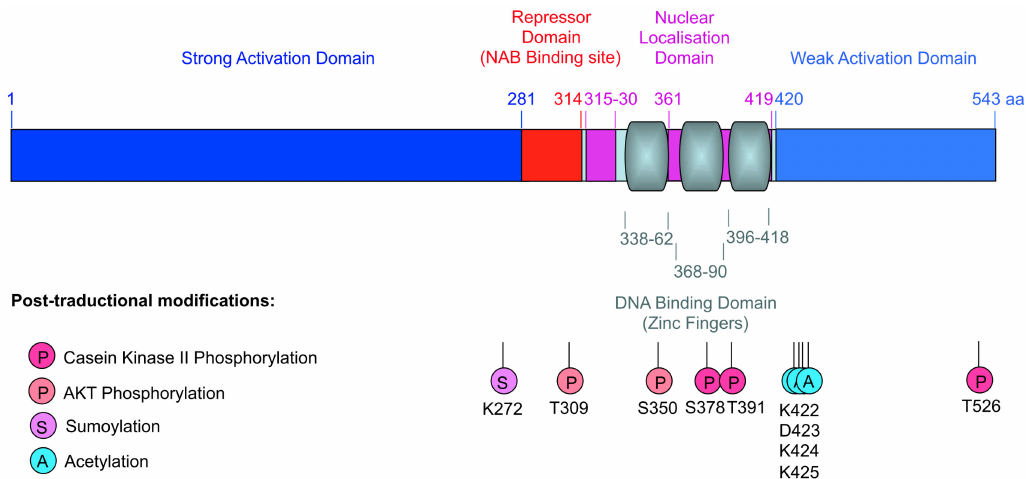
Figure 3. Schematic representation of the post-translational modifications on EGR1